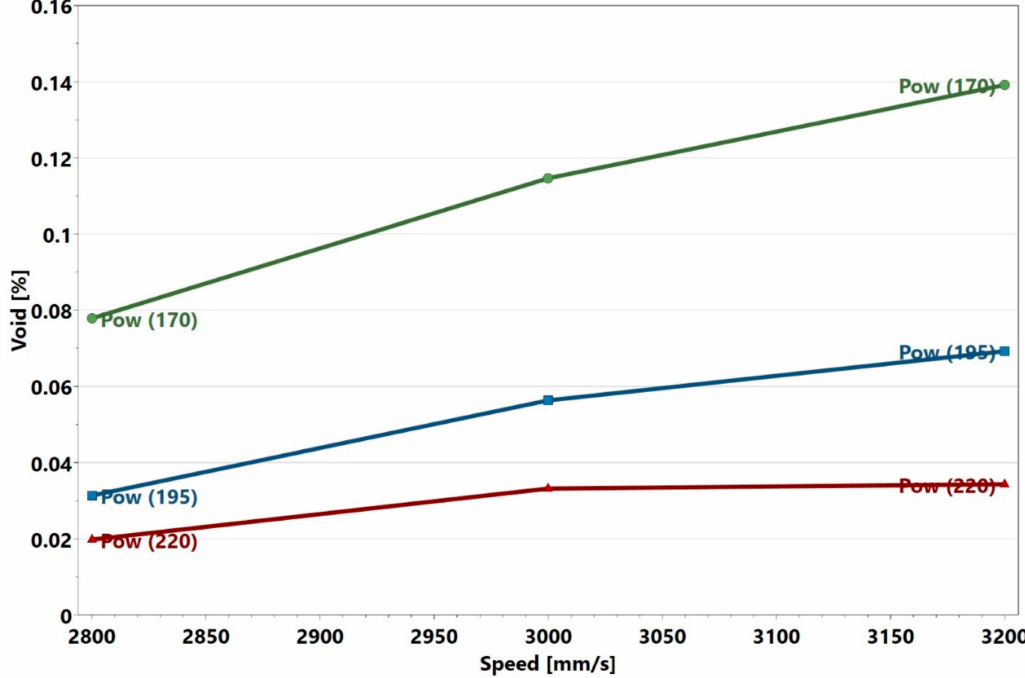
Figure 4. Power and speed interaction